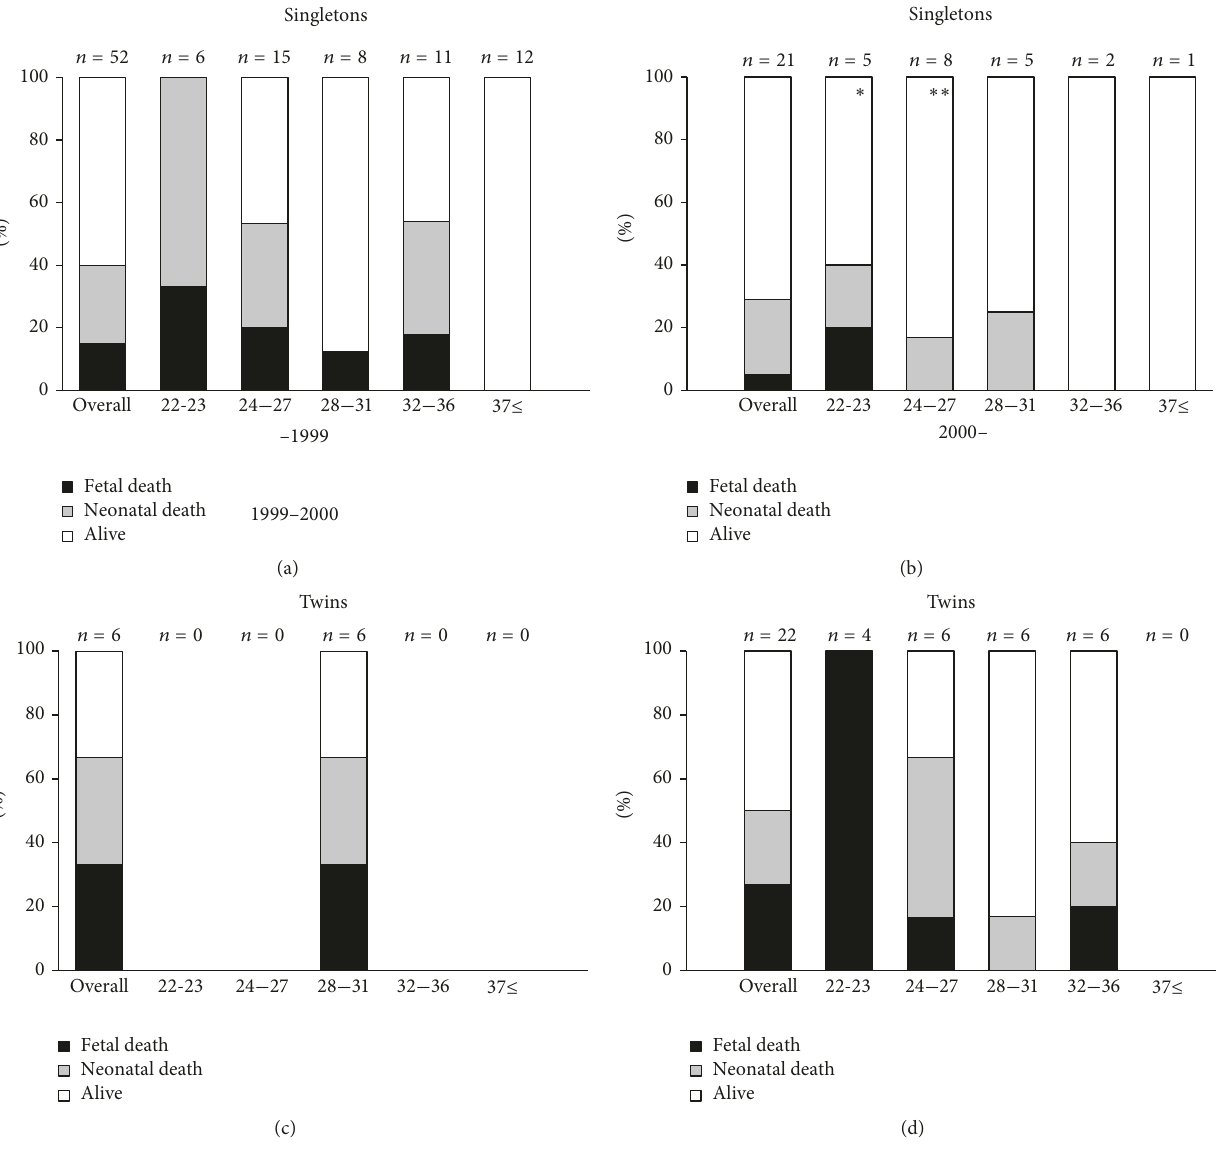
Figure 1: Perinatal mortality rate of infants with Candida chorioamnionitis born after 22 weeks’ gestation in the literature review. (a) Singletons born before 2000; (b) singletons born in 2000 or later; (c) twins born before 2000; (d) twins born in 2000 or later. Black bar: fetal death; gray bar: neonatal death; white bar: alive for the first 28 days of life. ∗ One infant died on day 59. ∗∗ One infant died on day 42. One twin of five twins without chorioamnionitis was excluded from